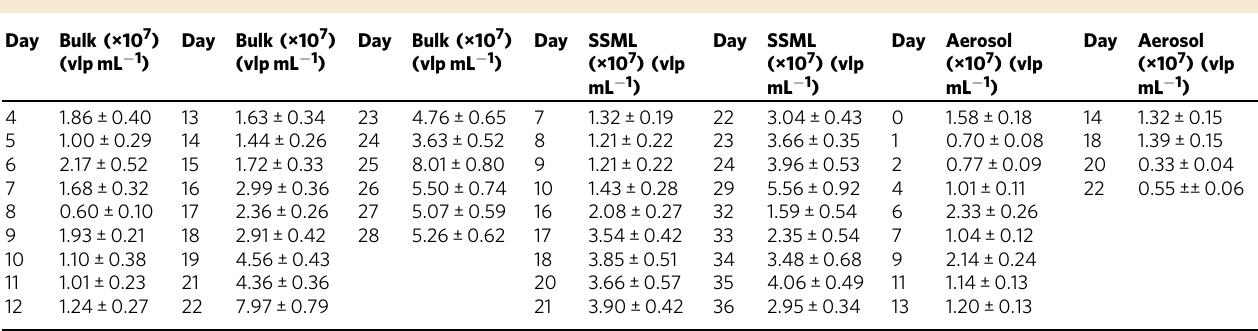
Error reported is s.d. and estimated error in aerosol measurements SSML sea surface microlayer, vlp virus-like